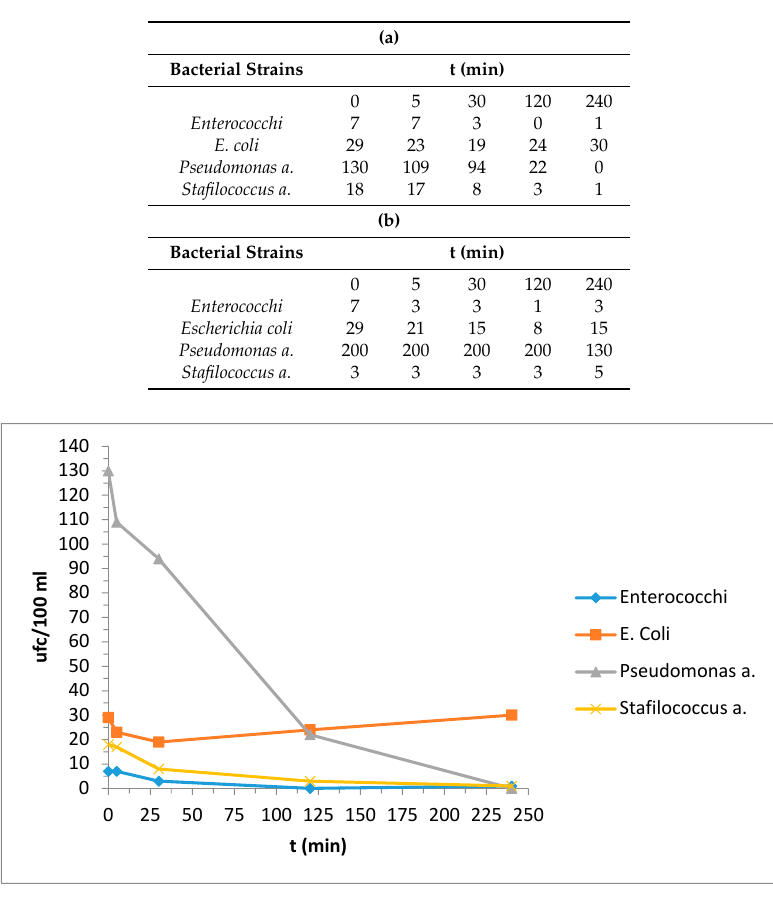
Figure 3. Evaluation of the concentration of the bacterial strains as a function of time.